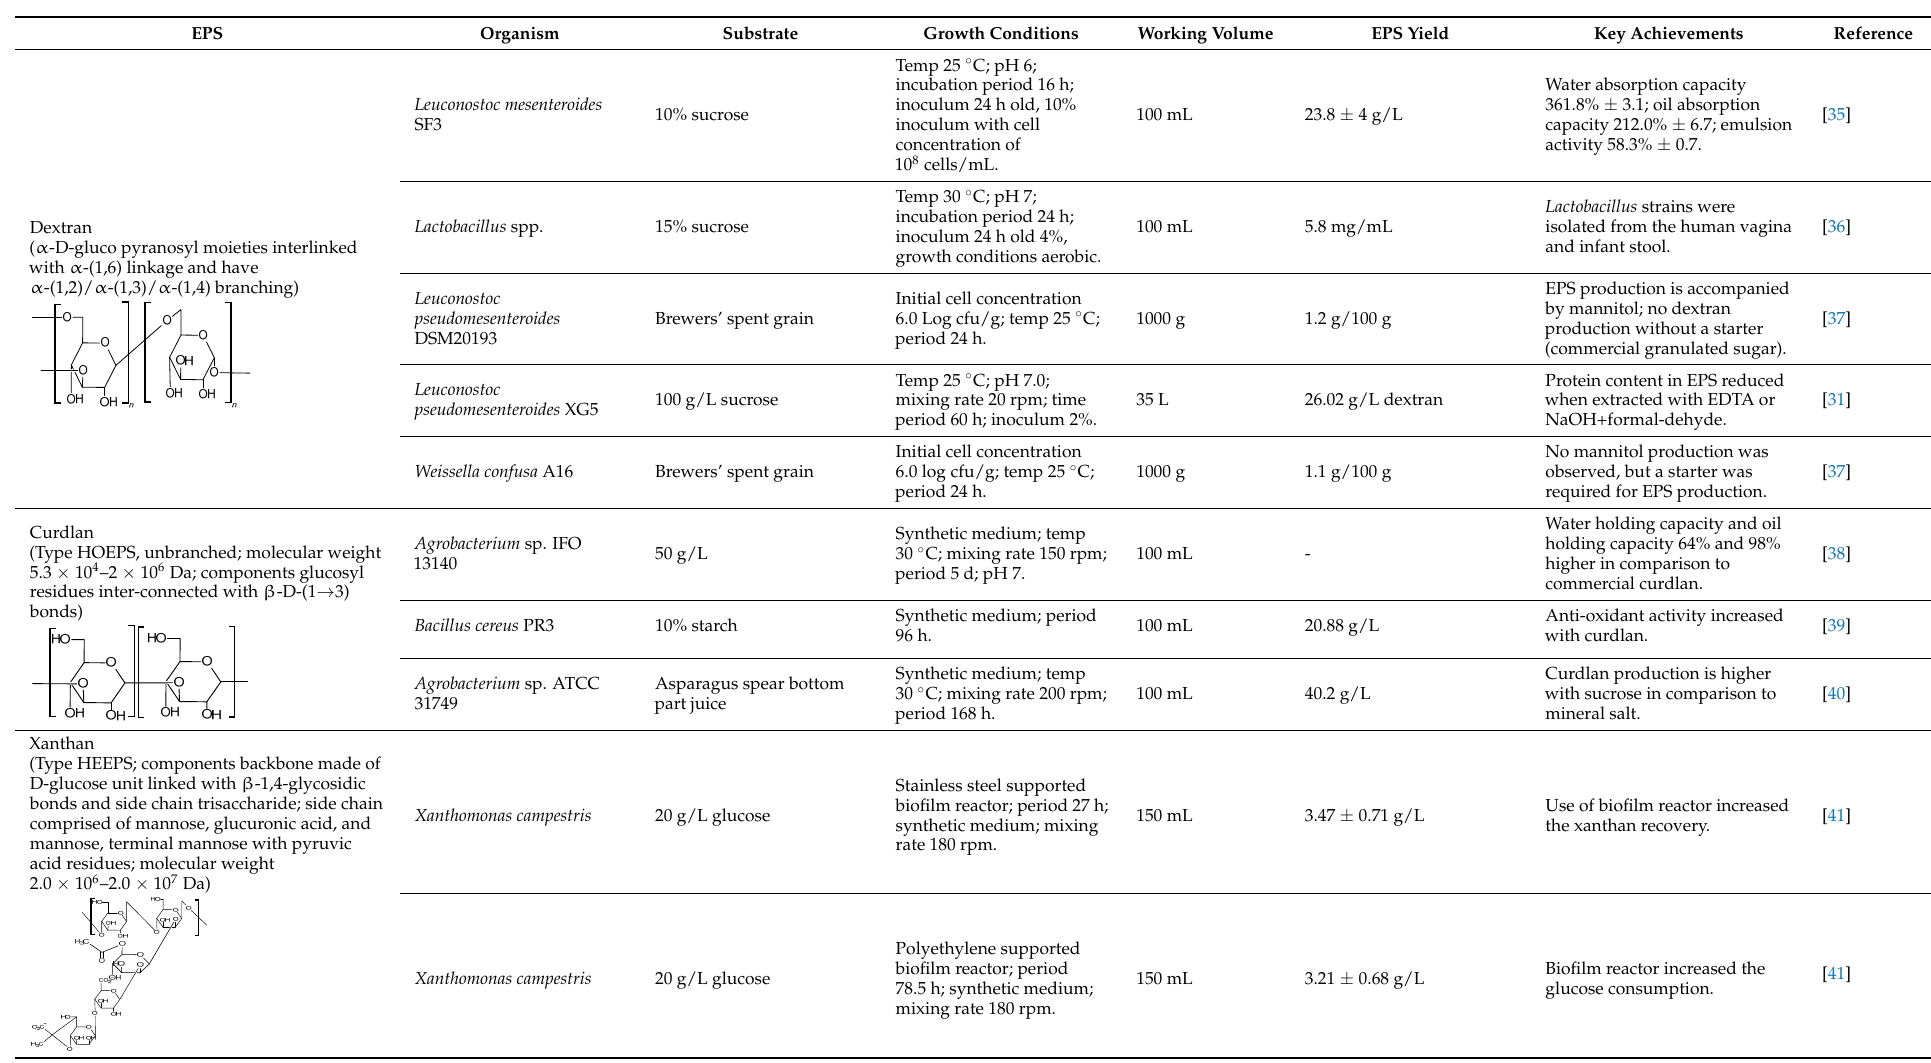
Table 1. Microbial production of EPS from various substrates.